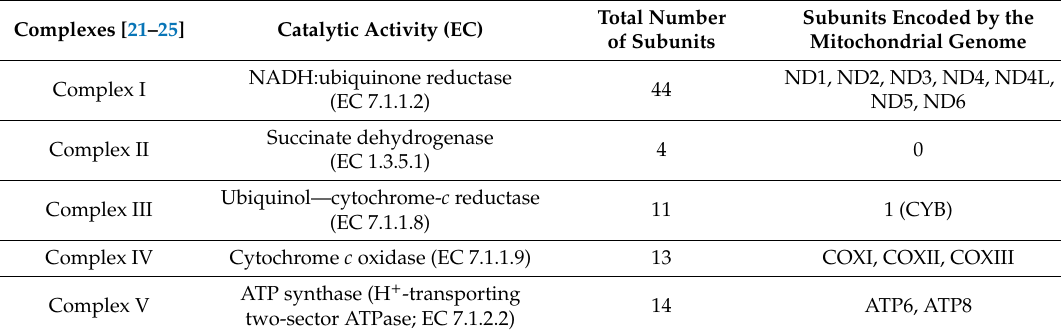
Table 1. Involvement of mtDNA in coding of components of mitochondrial